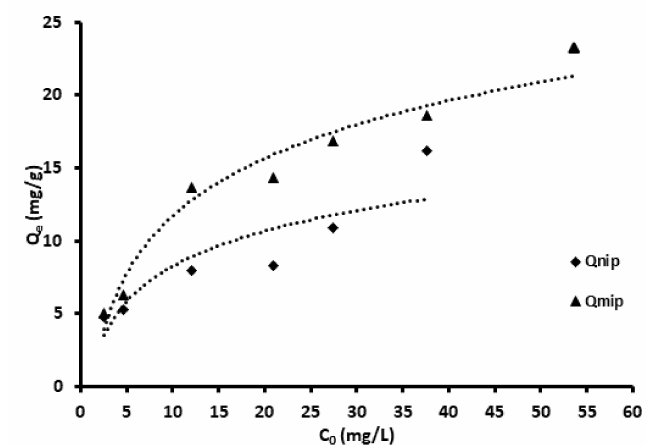
Figure 4. Adsorption capacity studies for the NIP and